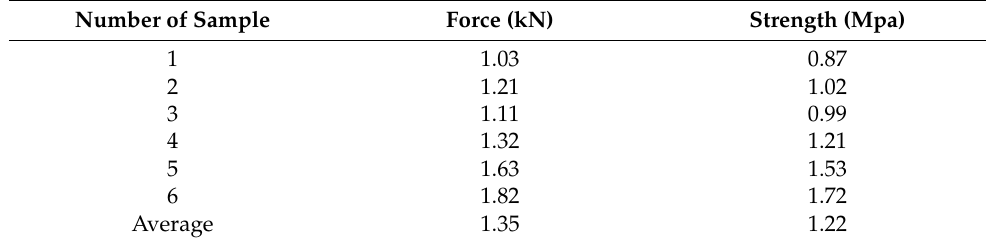
Table 5. Splitting tensile test for 28 days of curing.